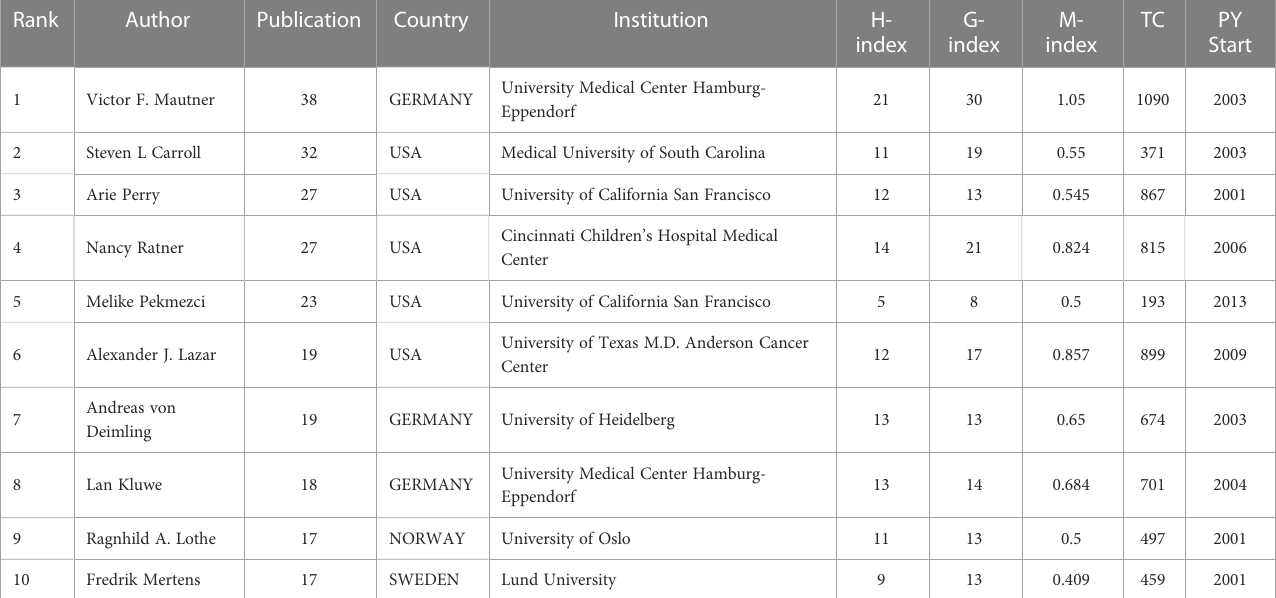
TABLE 3 The top 10 authors ranked by publications and